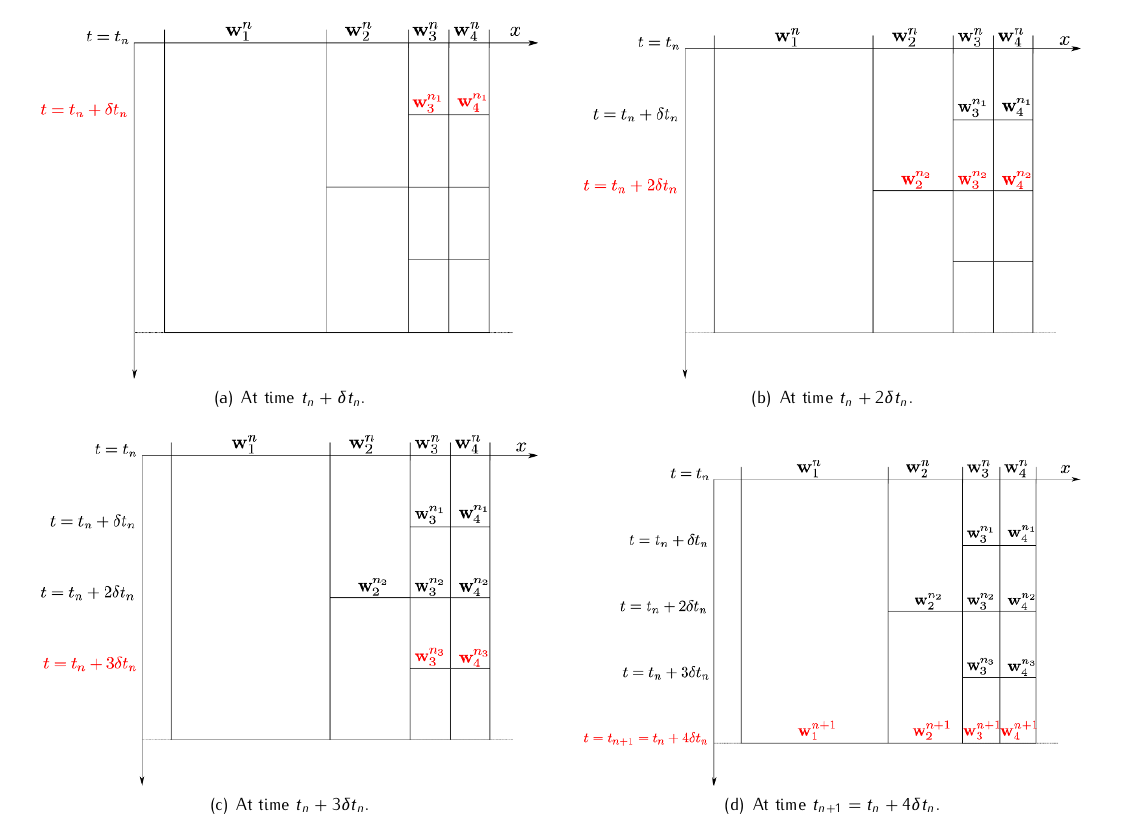
Figure 3. Illustration of the global time advancement for the first order scheme.